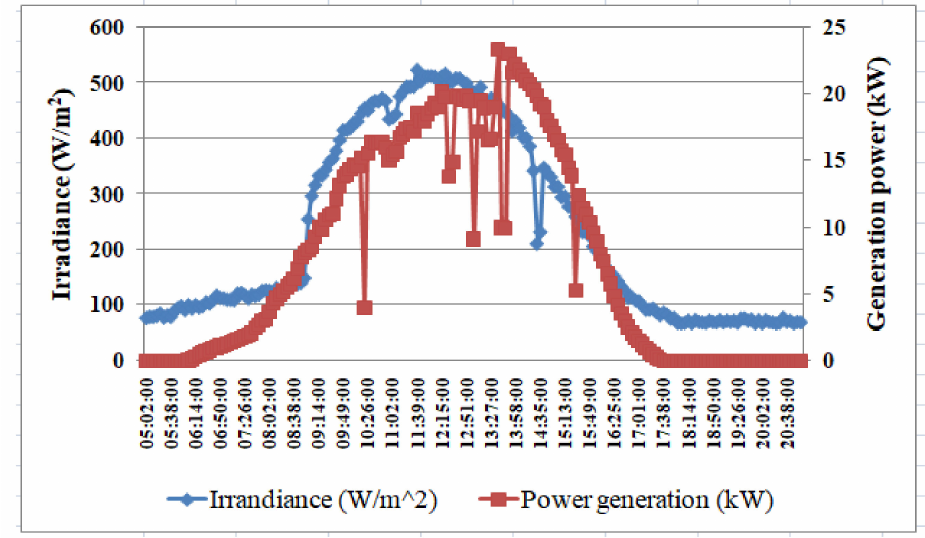
Figure 4. One day measured plant generation and radiation data on 17 March 2021 at RBI, Kolkata. Figure 5 describes the comparison among measured energy, and calculated energy without and with dust from 1 March 2021 to 31 March 2021. Solar irradiance for this one month period is also overlapped in this figure. From Figure 6, it is seen that before the day of cleaning on 17 March 2021, difference between calculated energy without dust and measured one is higher whereas this reduces afterwards. The expected energy generation loss due to dust is 32.2% on 4 March 2021 for the irradiance 3.08 kWh/m 2 , whereas after cleaning this loss is only 8.15% on 26 March 2021 for almost the same radiation 3.07 kWh/m 2 .